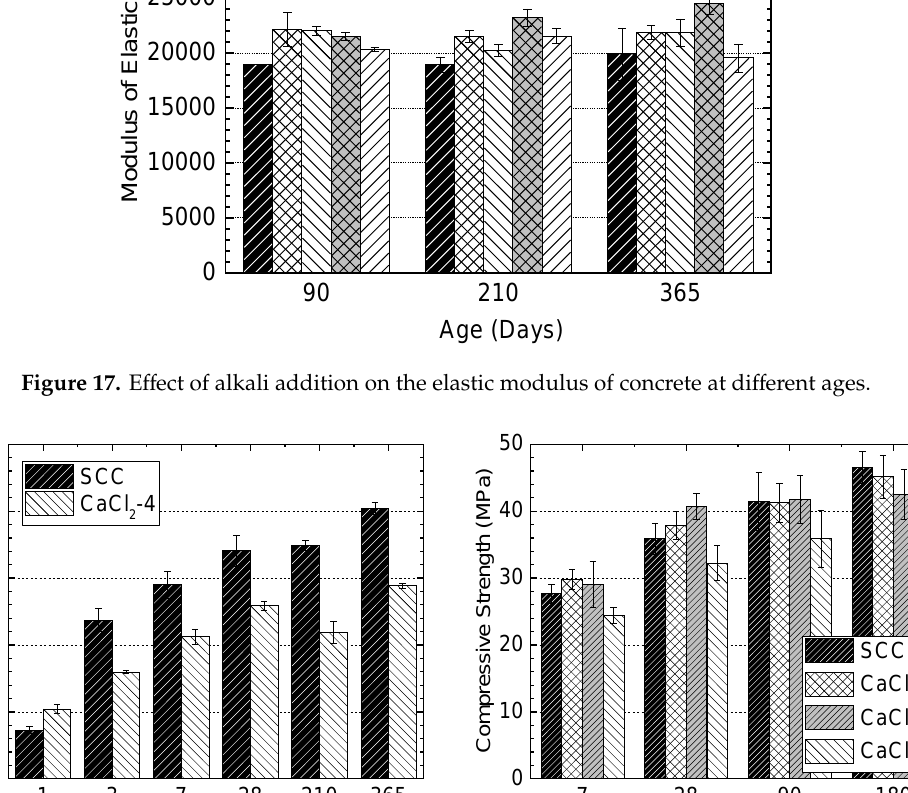
Figure 18. Effect of chloride ion on compressive strength at different ages: ( a ) SCC and CaCl 2 -4 mixtures from the larger batch series and ( b ) CaCl 2 mixtures from the smaller batch series. 1